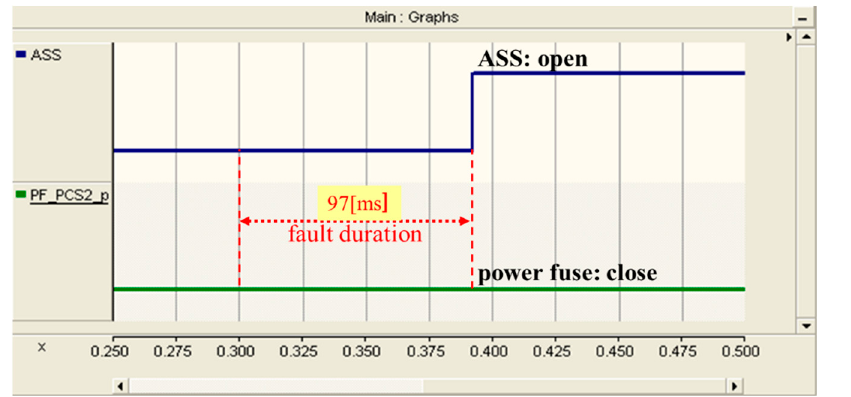
Figure 15. Conceptual diagram for high impedance.